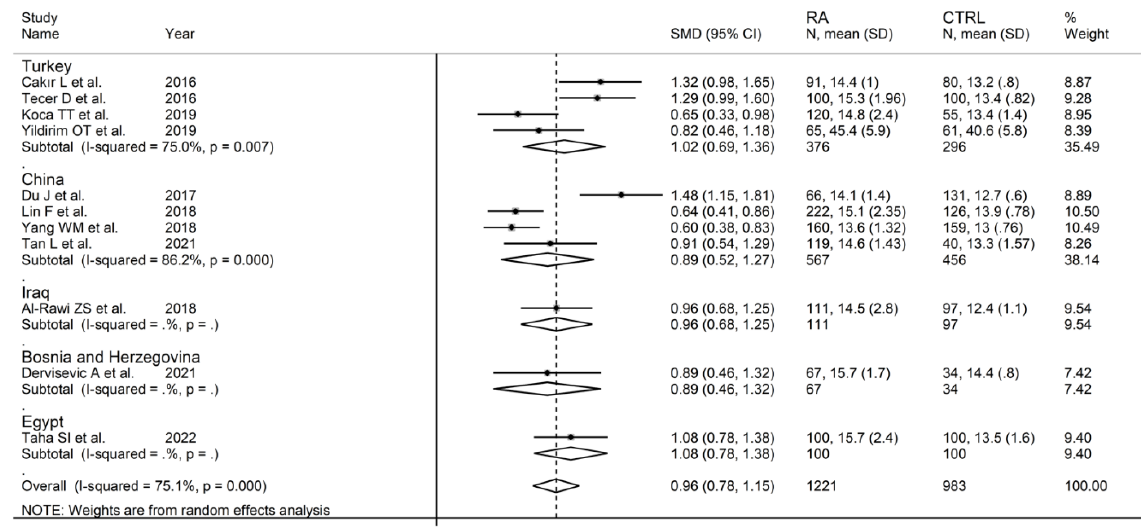
Figure 15. Forest plot of studies examining the red cell distribution width in patients with rheuma- toid arthritis and healthy controls according to study design.